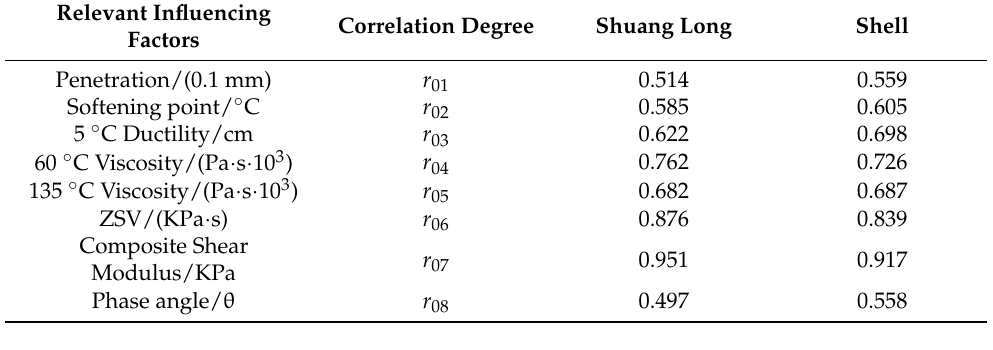
Table 9. Correlation degree of anti-rutting and the other properties.